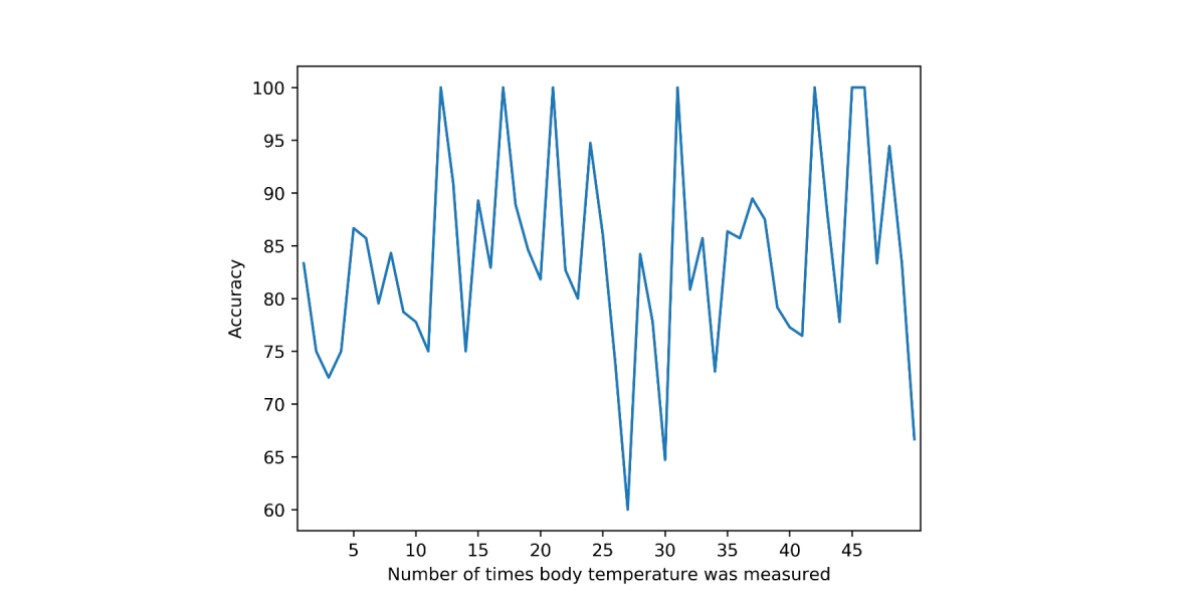
Figure 5. Screening performance versus the number of body temperature records. The y-axis shows the percentage of accuracy, and the x-axis refers to the number of body temperatures entered by the